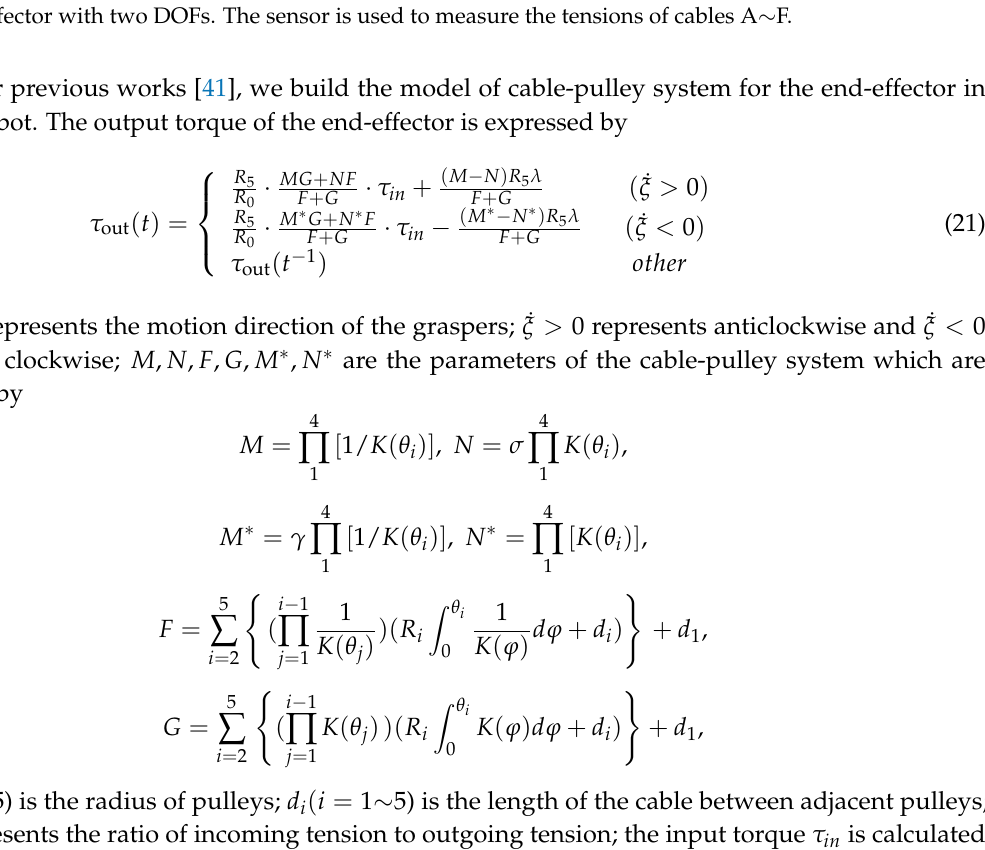
Figure 15. The structure of cable-pulley system in the end-effector. Six cables are used to control the end-effector with two DOFs. The sensor is used to measure the tensions of cables A ∼